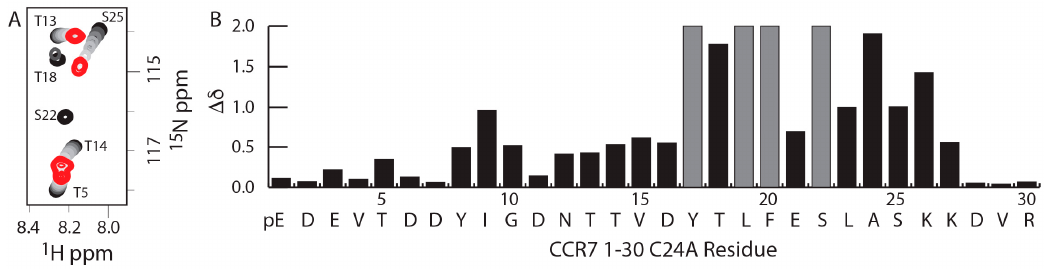
Figure 1. CCL21-induced chemical shift perturbations in the CCR7 N-terminus including tyrosine 8 and 17 and adjacent amino acids. ( A ) 15 N- 1 H HSQC spectra of 200 μ M U- 15 N/ 13 C CCR7 1–30 C24A in the absence (black) and with increasing concentrations of CCL21 (grays) at 1:2.5 CCR7:CCL21 molar ratio (red); ( B ) CCL21-induced CCR7 1–30 C24A chemical shift perturbations. A portion of glutamine 1 of CCR7 1–30 C24A spontaneously reacts to form pyroglutamate; hence, the pE or pyroglutamate label at position 1. CCR7 residues that broadened beyond detection during the titration are indicated in gray with a chemical shift of 2.